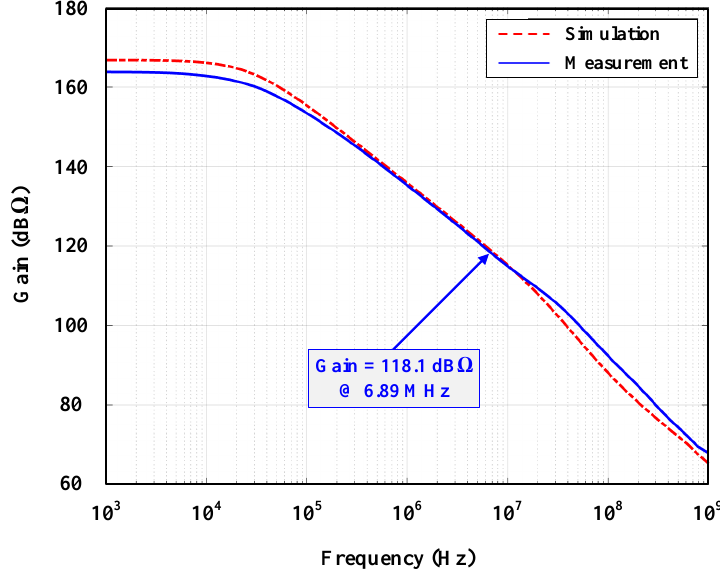
Figure 12. Measured TIA transimpedance gain compared to